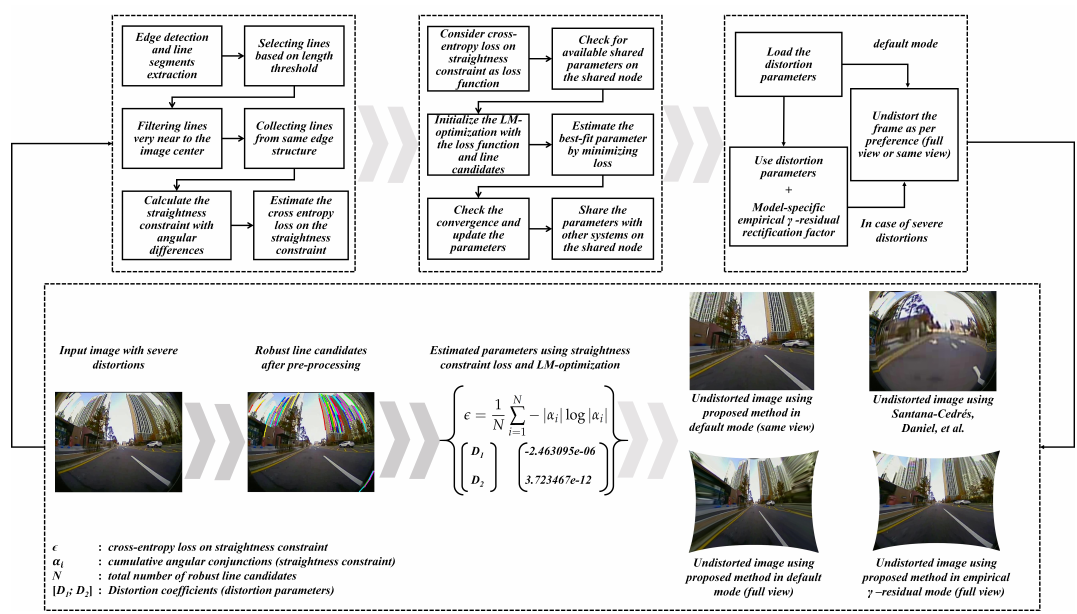
Figure 4. Proposed Self-calibration design.